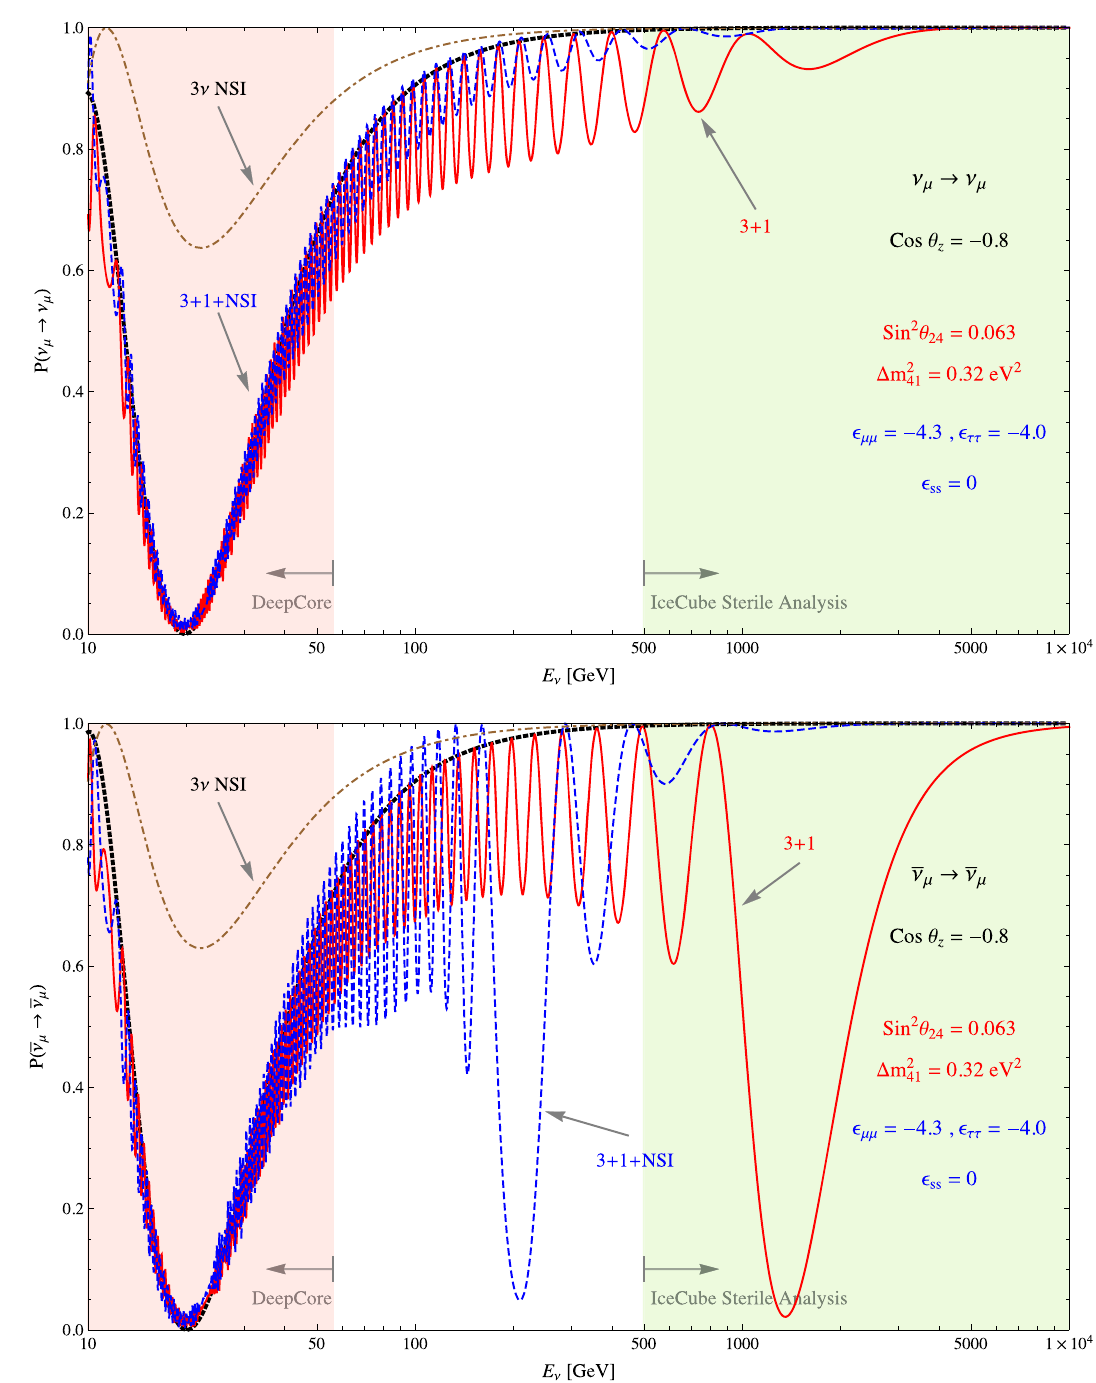
Fig. 1 The ν μ → ν μ (upperpanel)and ¯ ν μ → ¯ ν μ (lowerpanel)oscilla- scenario, with the parameters fixed to the case (a) shown in Table 1. For completeness, the case where only the NSI effect is added to the tionprobabilitiesasafunctionoftheneutrinoenergyforcos θ z = − 0 . 8. standard 3 ν oscillation is also shown by the brown dot-dashed curve. The black thick dashed curve corresponds to the 3 ν oscillation, while The energy ranges used by the IceCube’s sterile neutrino analysis [8] the red solid curve corresponds to the 3 + 1 model with sin 2 θ 14 = 0 . 02, = 0 . 32 eV 2 (all the other parameters of the and the DeepCore oscillation analysis [28] are indicated by the green sin 2 θ 24 = 0 . 063 and Δ m 2 41 and pink shaded regions, 3 + 1 model are set to zero). The blue dashed curve indicates the case where the NSI is added on top of the 3 + 1 model, the ( 3 + 1 ) + NSI